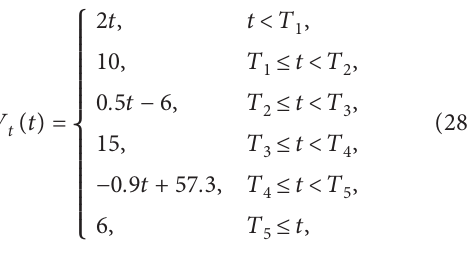
c � 1.5 are used in the vehicle path-following analysis. To fit v into the vehicle path-following in sinusoidal segment, � 4 and k � 20 are used while they are control parameters c θ θ 12 and 5 in the straight or circular segment of the path,